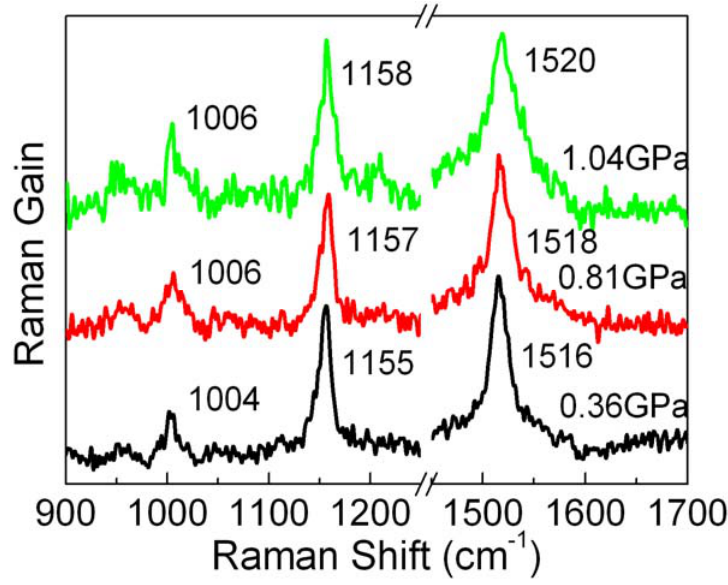
Figure 2. Raman spectra of lycopene in n -hexane under different